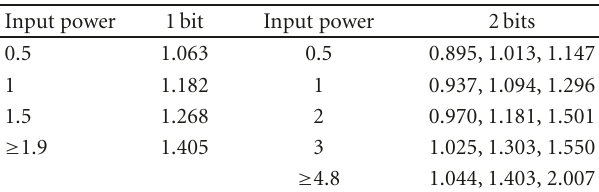
Figure 11: Power-independent optimal quantization boundaries for di ff erent values of error probability in the detection model, CG distribution: Nakagami, μ = 2. Table 5: Optimal quantization boundaries, unreliable quantization region detection, long-term power constraint, and CG distribution: Nakagami, μ = 2, w = 1, Pe = 0 .